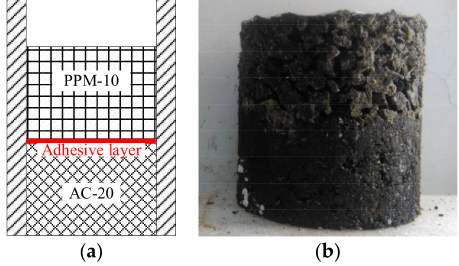
Figure 1. Preparation of composite specimen: ( a ) Schematic illustration and ( b ) picture of real specimen.